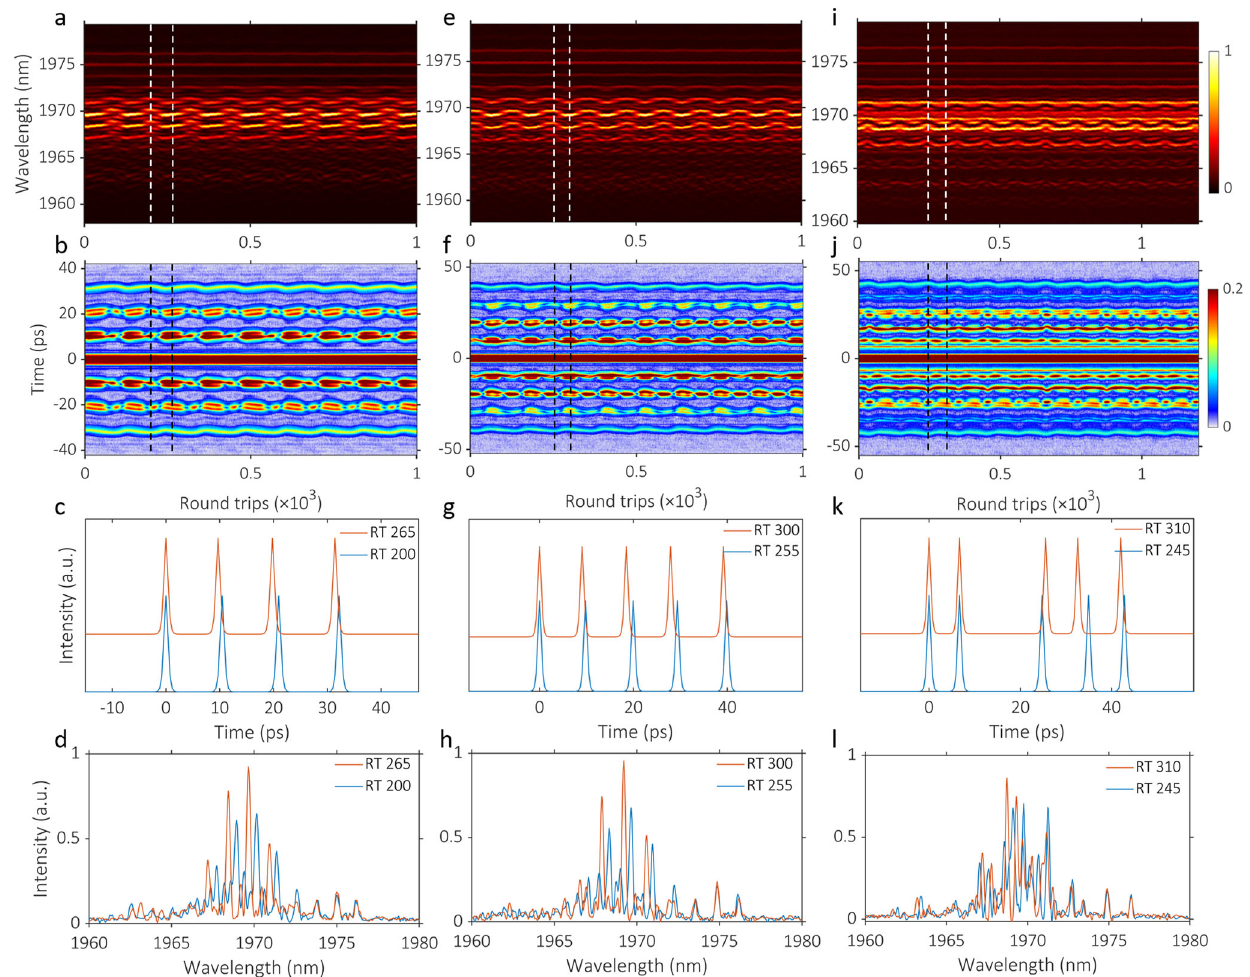
Fig. 2 Experimentally observed periodic switching of oscillating soliton molecular complexes with dual-stability. a – d Periodic switching of oscillating soliton quartet molecule. e – h Periodic switching of oscillating soliton quintet molecule. i – l Periodic switching of (2 + 3) oscillating soliton molecular complexes. a , e , i The real-time spectral evolution measured via DFT. b , f , j The corresponding fi eld autocorrelation traces. The temporal pulse distribution in ( c , g , k ) and single-shot spectrum in ( d , h , l ) of several typical RTs corresponds to the black dashed lines in ( b , f , j ),